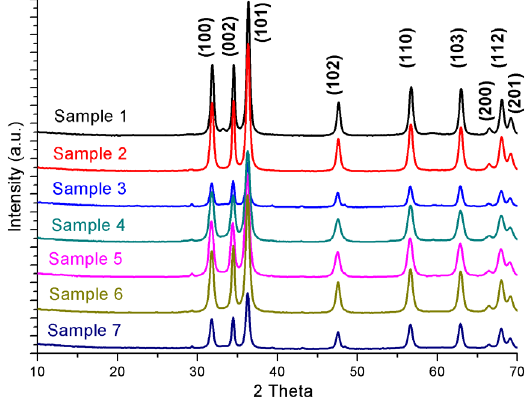
Figure 2. XRD spectra of ZnO obtained in ionic liquids media. Table 1. ZnO samples prepared in media based on ionic liquids. Sample